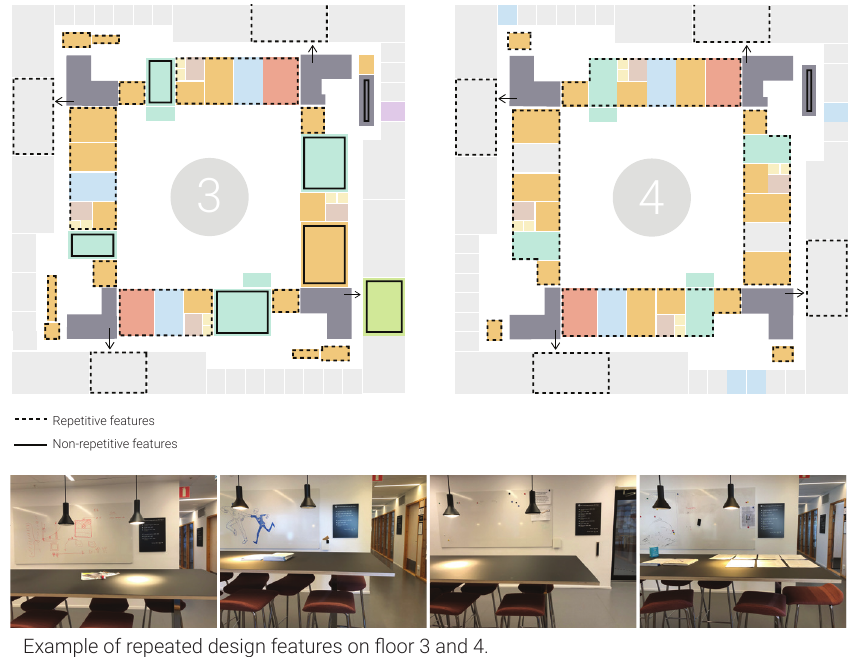
Figure 5. Wayfinding in the office space.